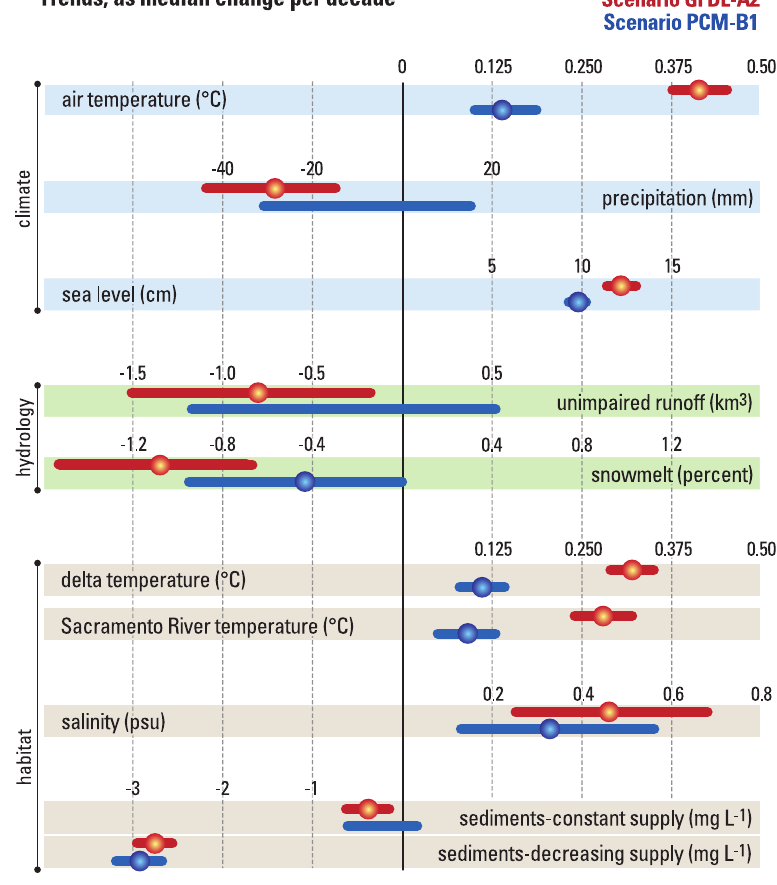
Figure 3. Projected 2010–2099 changes in nine environmental indicators, expressed as median trend per decade, for the A2 scenario (red) and B1 scenario (blue). Statistically significant (p , 0.05) trends are indicated with solid circles; horizontal lines show 95% confidence limits of the trend estimates.